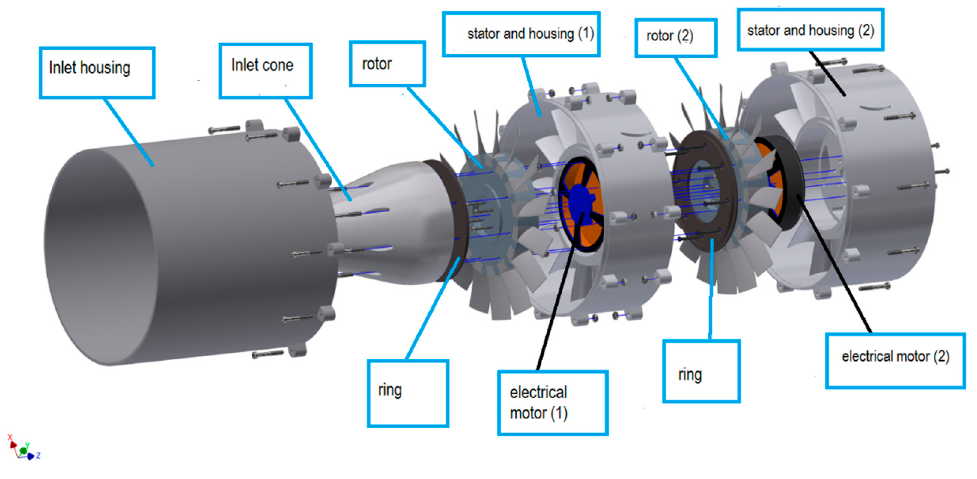
Figure 3. The developed design model of the two-stage axial fan .